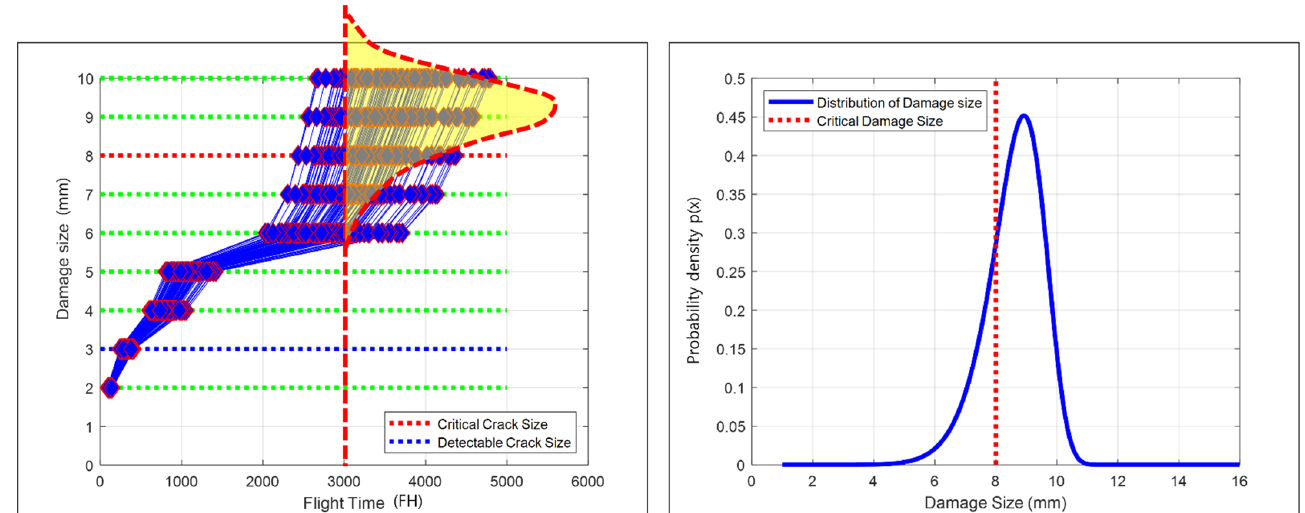
Figure 14. Single flight probability of failure calculation at 3000 FHs.